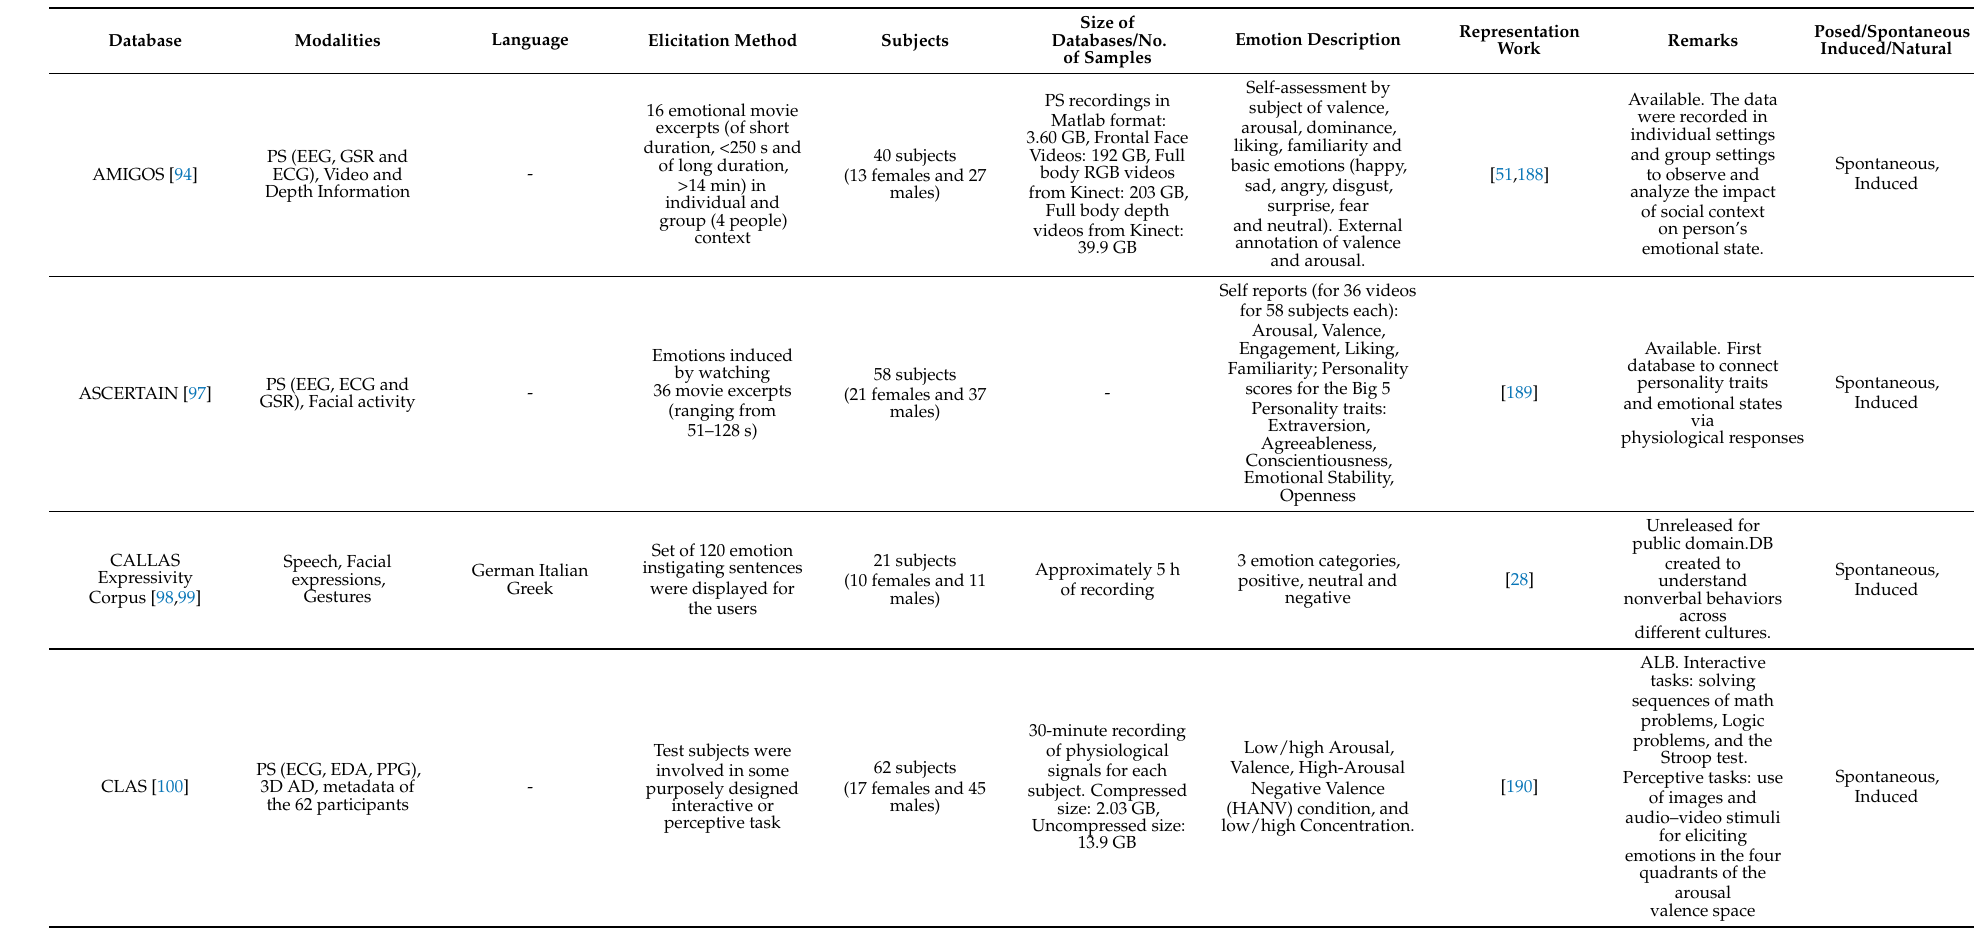
Table 2. Multimodal Databases: A Detailed